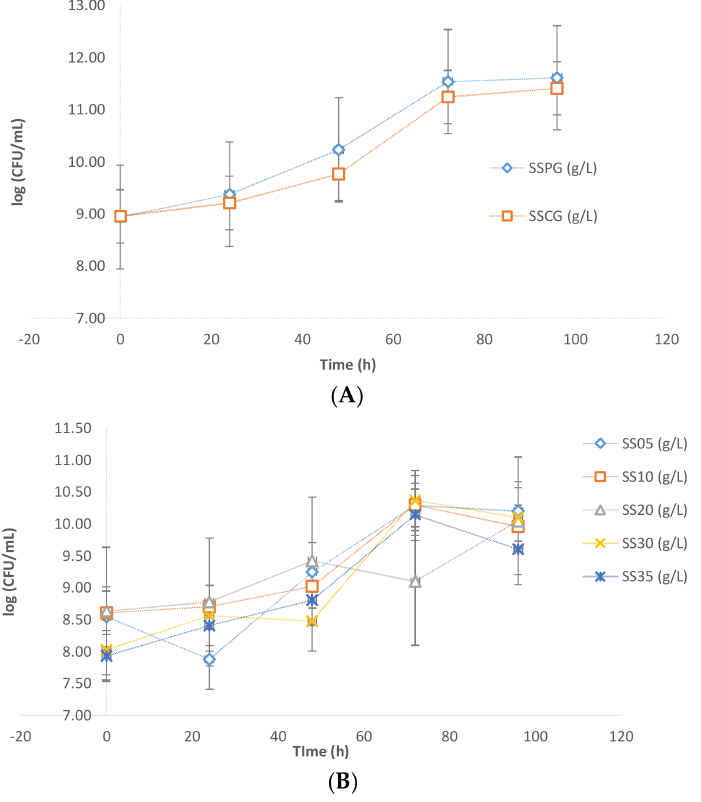
Figure 3. ( A ) CFU profiles comparison between pure glycerol (SSPG) and crude glycerol (SSCG); ( B ) CFU profiles for flask fermentation containing different concentrations of sludge